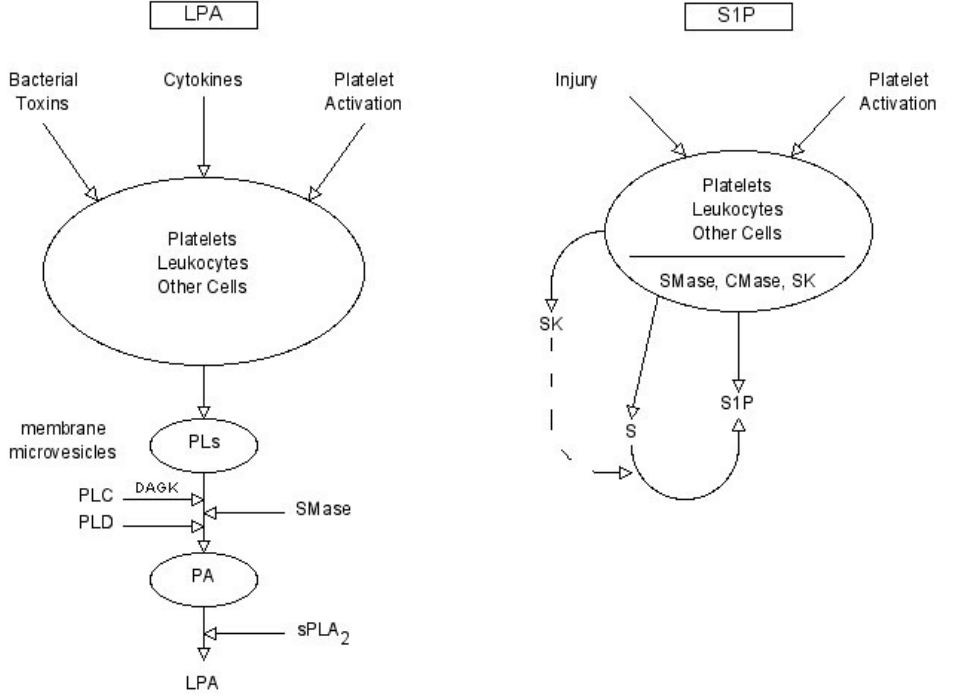
FIGURE 1. Cellular generation and release of lysophospholipid mediators. PL = phospholipid, PLC = phospholipase C, PLD = phospholipase D, DAGK = diacylglycerol kinase, sPLA2 = secretory phospholipase A2, PA = phosphatidic acid, SMase = sphingomyelinase, CMase = ceramidase, S = sphingosine, SK = sphingosine